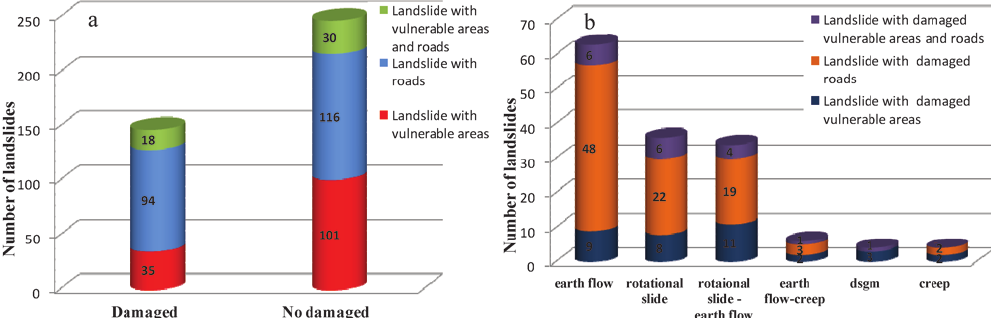
Fig. 18. (a) Number of landslides with or without damaged vulnerable areas and/or roads; (b) number of landslides with damaged vulnerable areas and/or roads distinguished according to the type.